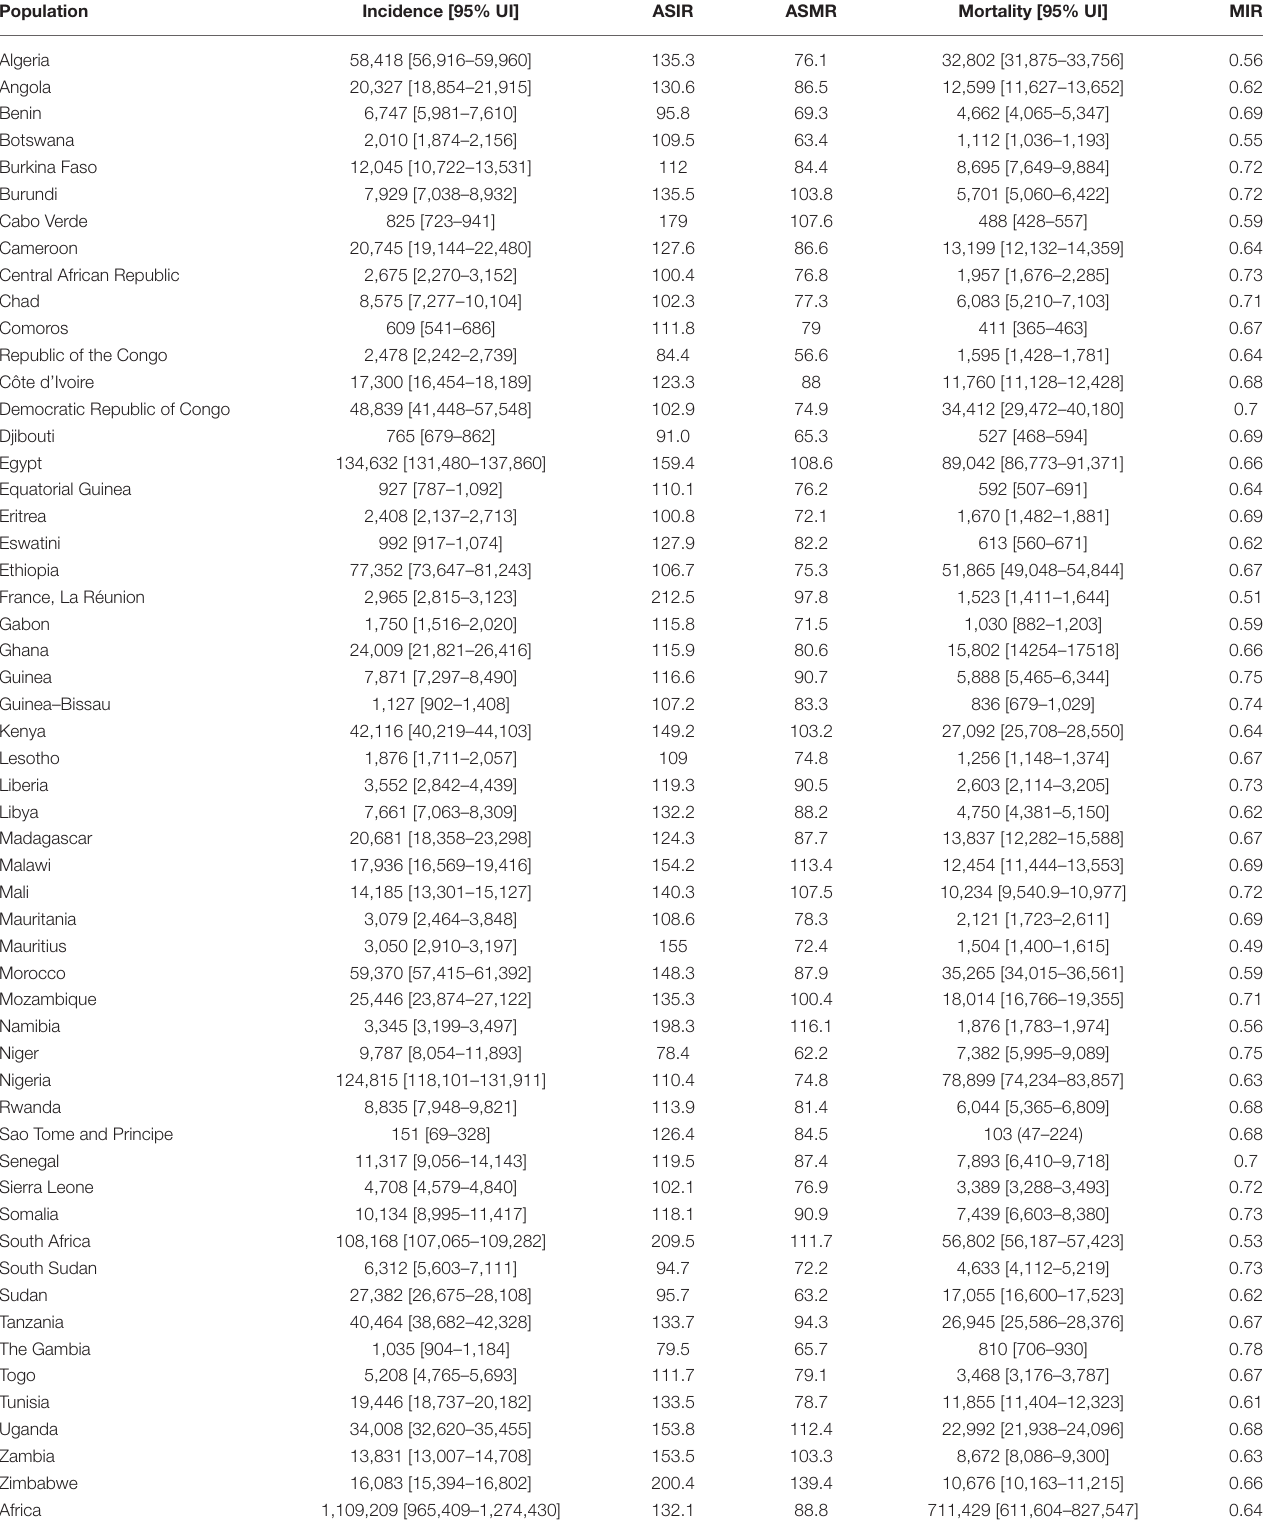
TABLE 1 | Aggregate cancer burden in 54 African countries in